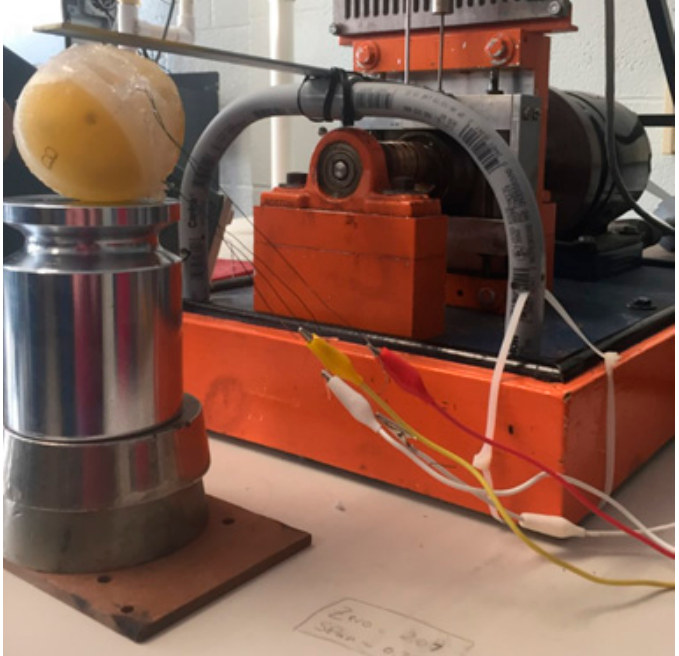
Figure 5. Variable speed Scotch Yoke apparatus with a custom setup used to test the energy harvester at different oscillating rates.